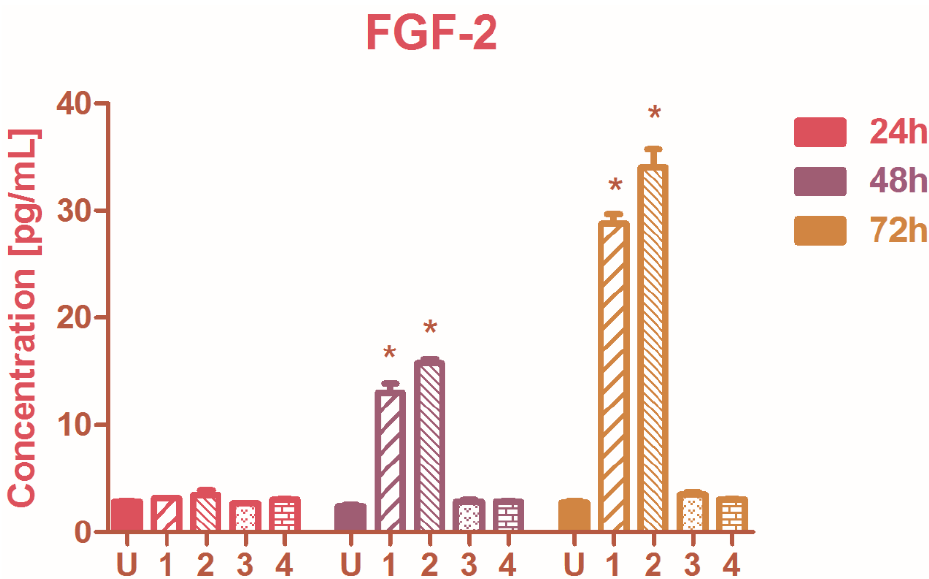
Figure 4. The influence of ruthenium complexes 1 − 4 on FGF-2 secreted by the ovarian cancer cells treated in vitro for 24-, 48-, or 72-h; U represents the untreated control, and the starred columns indicate a significant increase in FGF-2 production in measured up to untreated control cells. Starred columns represent the significant changes versus the untreated control.